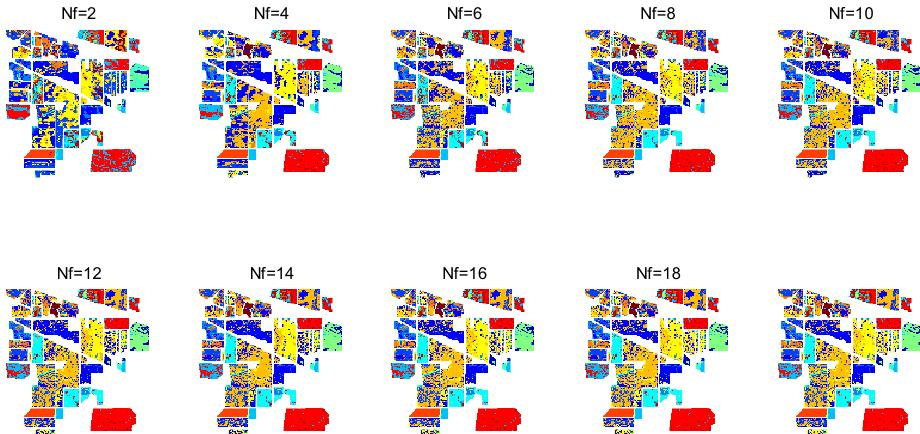
and different (cid:13) for Indiana dataset 3 = 10 4